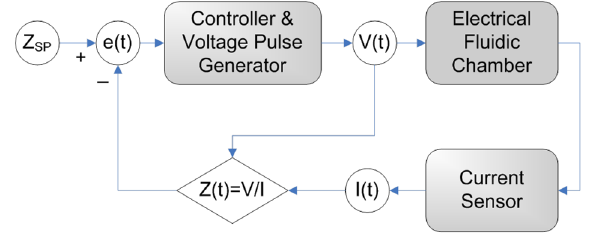
Figure 7. The block diagram of the impedance based temperature regulation scheme. The electric current supplied to the electrodes is measured and used as a proxy for the temperature of the chamber liquid. A feedback loop controls the voltage pulse train and maintains the chamber impedance at a pre-set value.